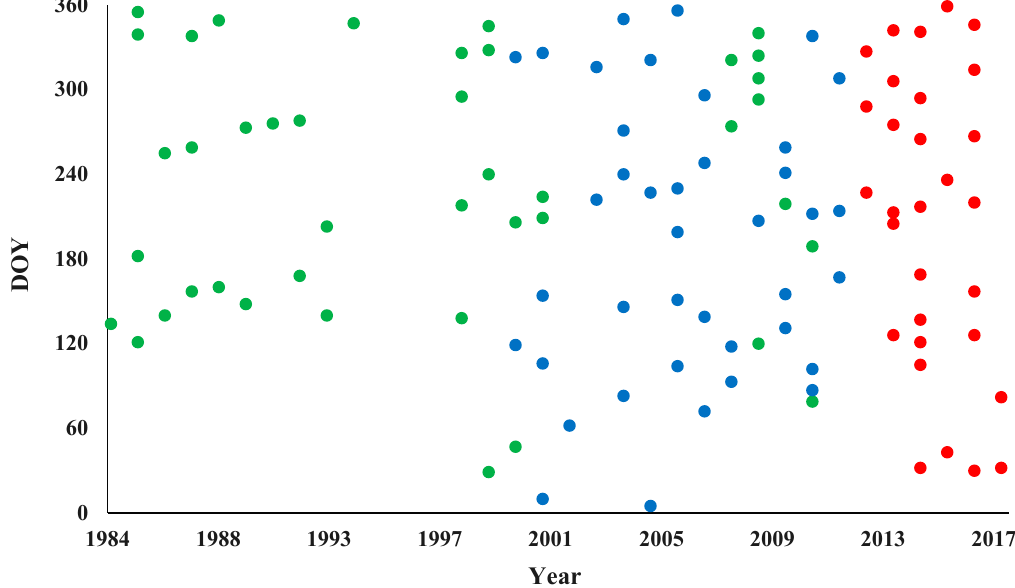
Figure 2. Landsat data for current study. Color code: Green, Landsat 5; Blue, Landsat 7; and Red, Landsat 8.